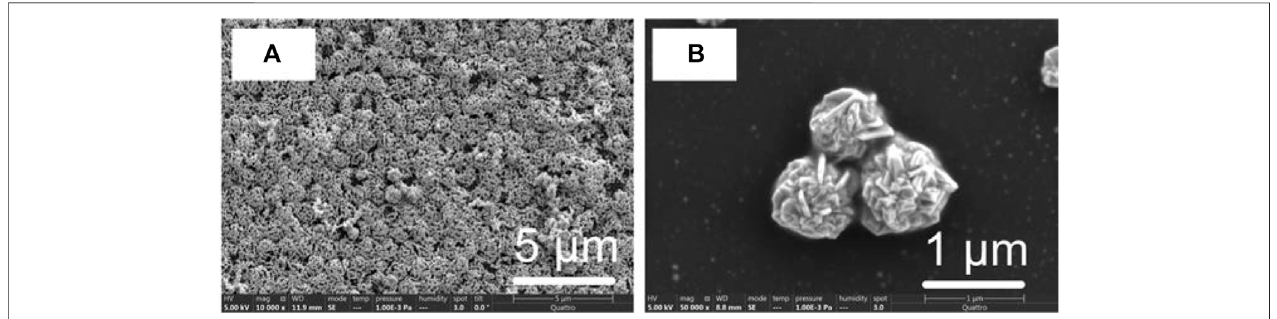
FIGURE4 |(A) SEMimageofgold nanocluster arrayformed at areductiontimeof1 h with the assistance ofthe laser-treated MoS of gold nanocluster composed of gold nanoplates.